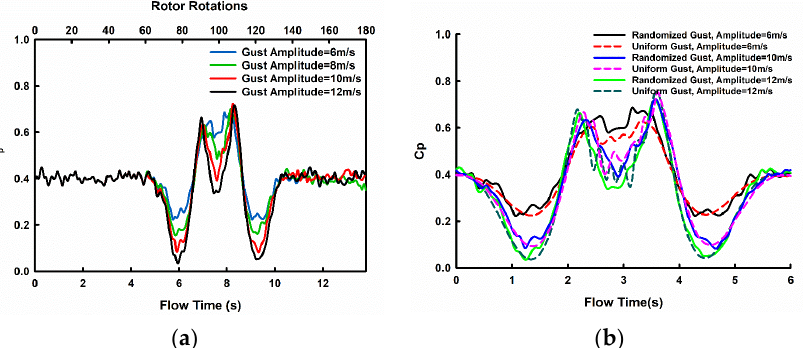
Figure 20. ( a ) Variation of C p for flow time for Ugust = 6 m/s, 8 m/s, 10 m/s, and 12 m/s; ( b ) Compar- ison of C p of randomised gust velocity case with uniform gust velocity case against flow time.